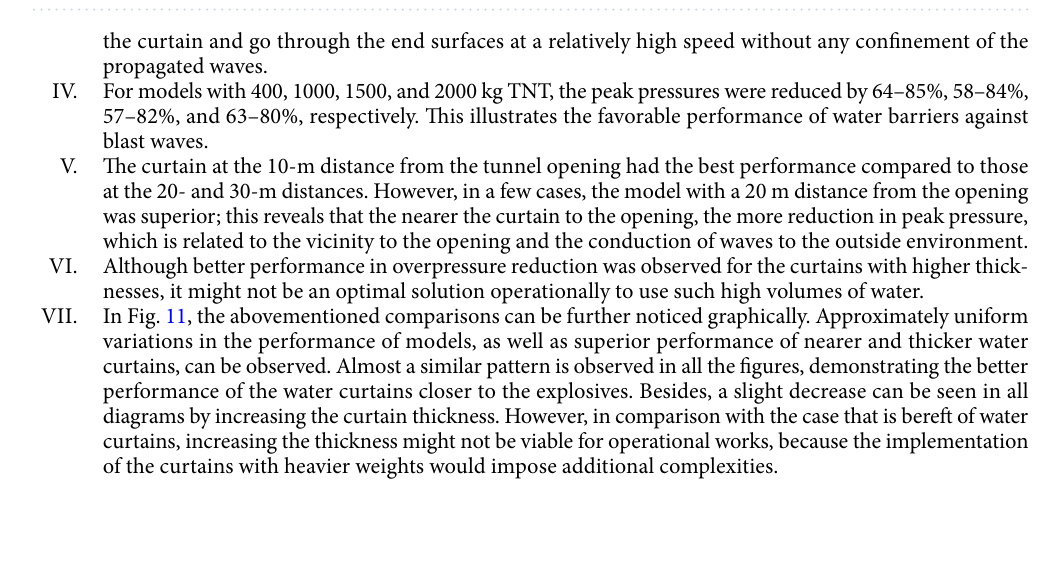
Figure 11. Peak pressures of different models for various TNT charges: ( a ) 400 kg, ( b ) 1000 kg, ( c ) 1500 kg, ( d ) and 2000